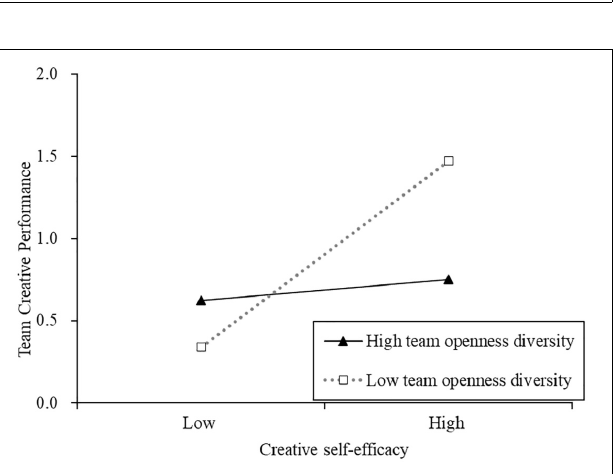
FIGURE 3 | Team variance on openness—creative self-efficacy interaction for team creative performance.